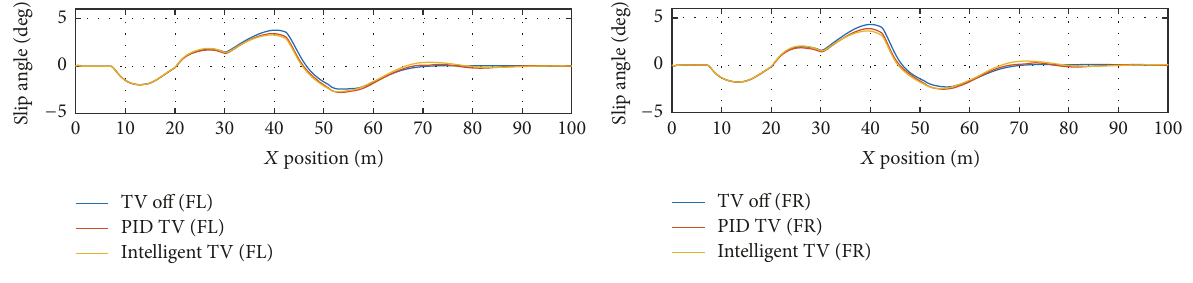
Figure 19: Wheels slip angles.